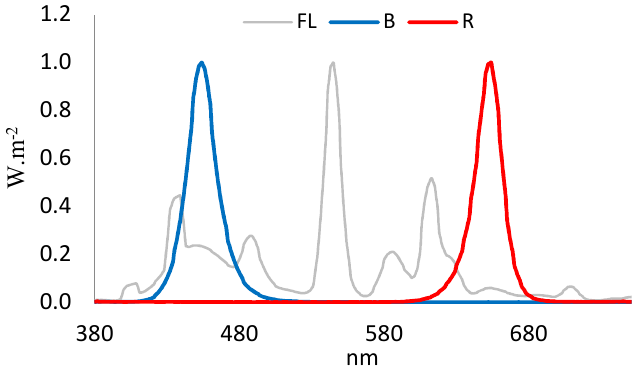
Figure 1. Spectral composition in different light treatments: blue (B), red (R) light-emitting diodes (LEDs), and fluorescent light (Fl). Peak wavelength numbers are shown for each broadband.